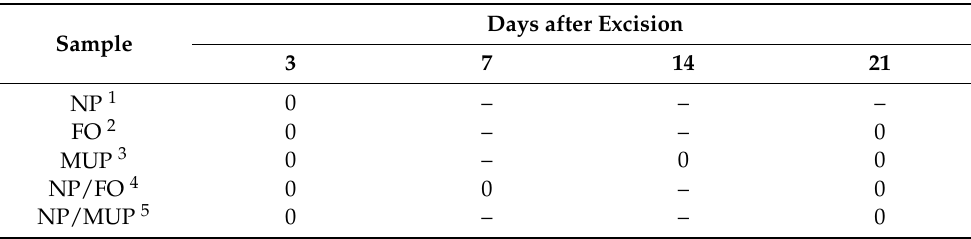
1 Dressing with empty poly(lactic-co-glycolic) acid (PLGA)-polyvinyl alcohol (PVA) nanoparticles (NPs). 2 Dressing with fish oil. 3 Dressing with mupirocin. 4 Dressing with PLGA-PVA NPs with entrapped fish oil. 5 Dressing with PLGA-PVA NPs with entrapped mupirocin.